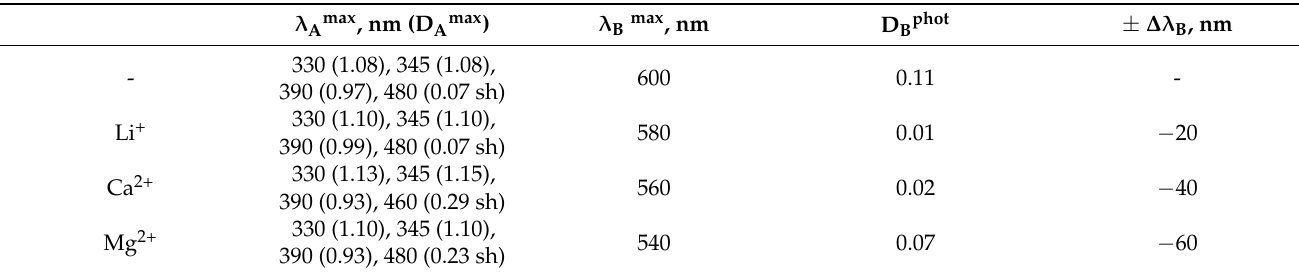
λ Amax and λ Bmax –are wavelengths for maxima of the absorption bands of A and B forms, correspondingly; D Amax is the absorption in the maximum of the absorption band; D Bphot –is a change in the optical density at the maximum of the absorption band in the visible region of the B form spectrum; ± ∆ λ B –is a shift of the absorption band maximum of photoinduced form B in the presence of metal ions relative to the solution without